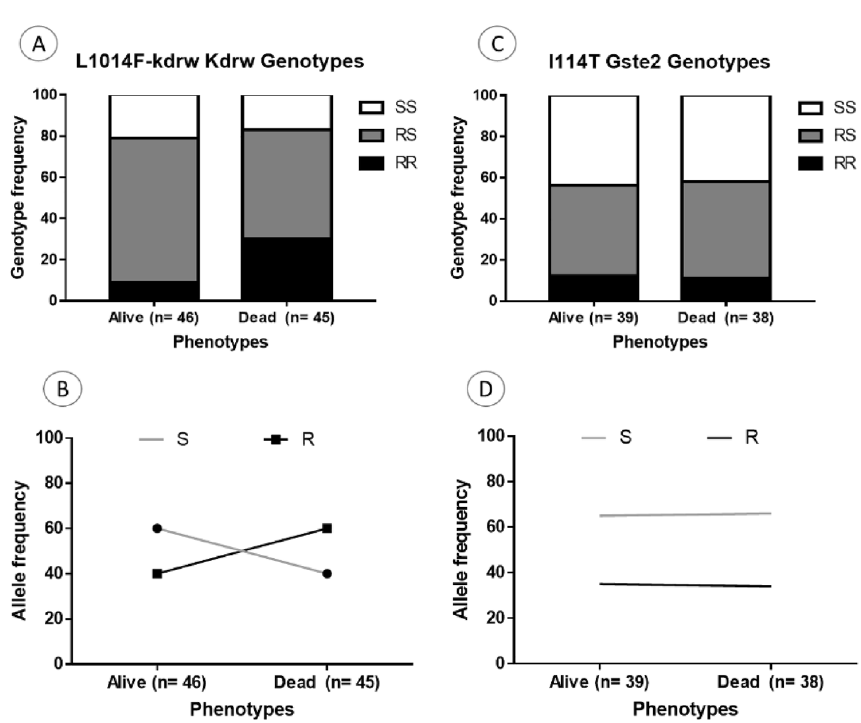
Figure 6. Association between pyrethroids resistance markers and resistance to chlorfenapyr in An. gambiae . Distribution of the L1014F-Kdr_w genotypes ( A ) and alleles ( B ) among the dead and alive mosquitoes after exposure to chlorfenapyr and ( C ) and ( D ) for I114T-GSTe2. R represents the resistant allele while S represent the susceptible